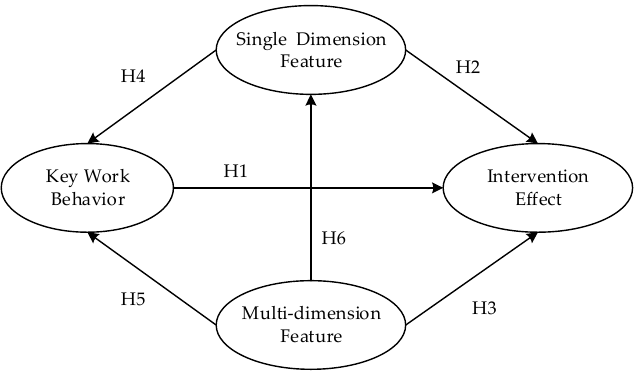
Figure 3. Initial model of miners’ targeted unsafe behavior intervention node evaluation.